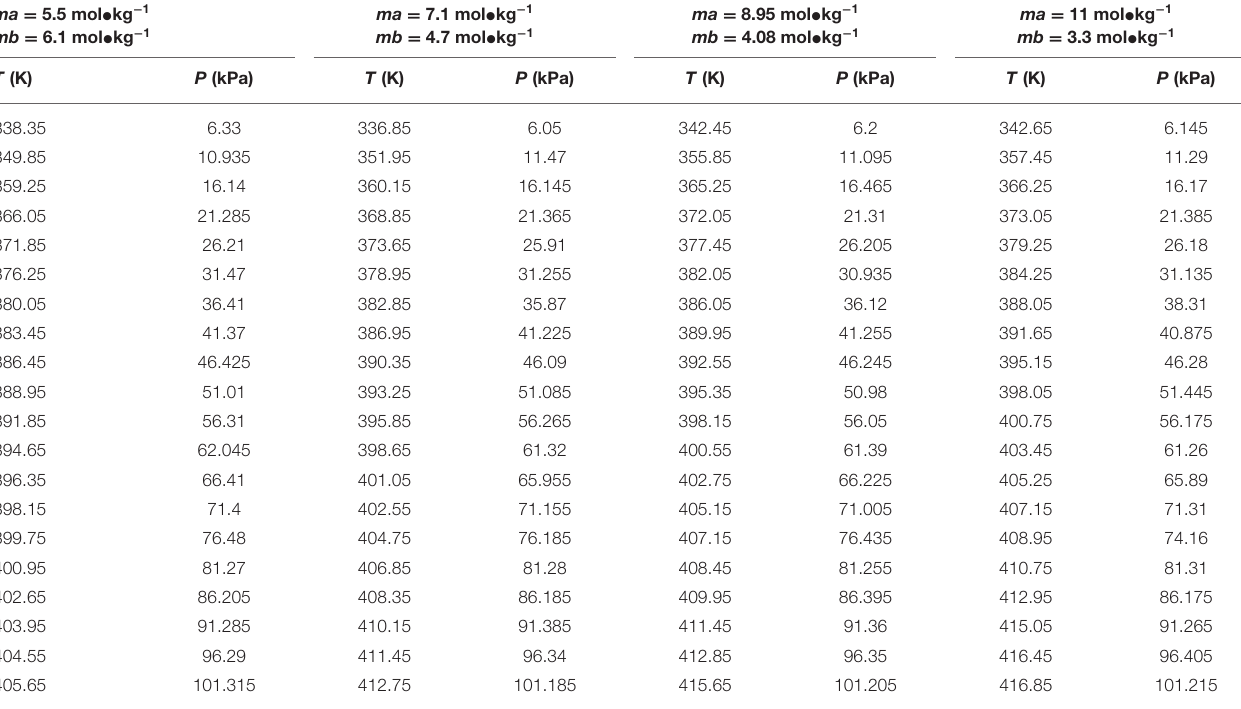
TABLE 5 | Experimental VLE data for temperature T , pressure P , and molality m ( ma— LiBr, mb— CaCl 2 ) for the LiBr + CaCl 2 + H 2 O